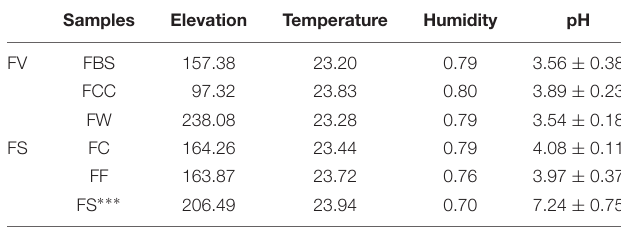
TABLE 1 | Comparison of the climate conditions and pH among samples.